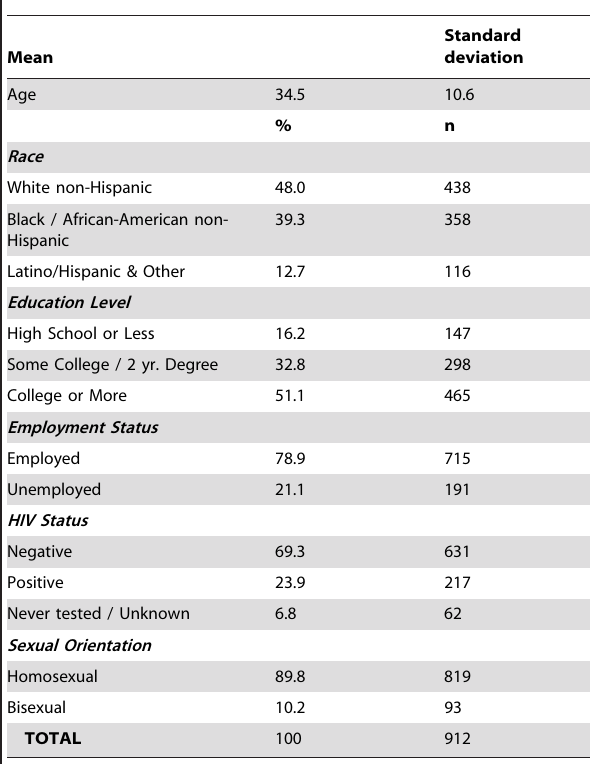
Table 1. Sample characteristics (n